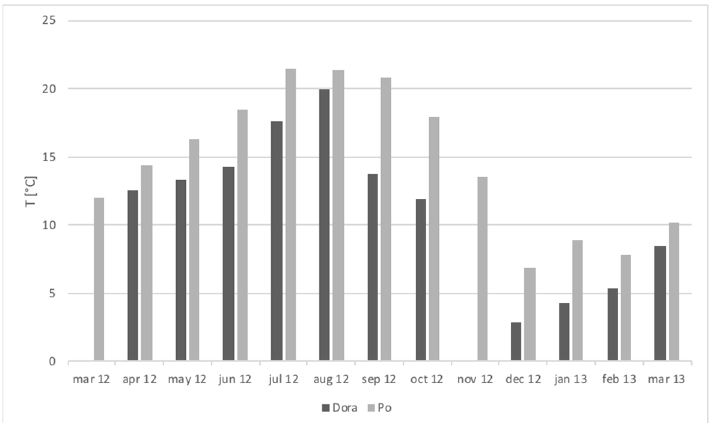
Figure 1. Monthly water temperatures of the Dora Baltea and Po Rivers from March 2012 to March 2013 (monthly average from [24] for April–July 2012, otherwise, point measurement data from ARPA Piemonte institutional monitoring network and [24]).